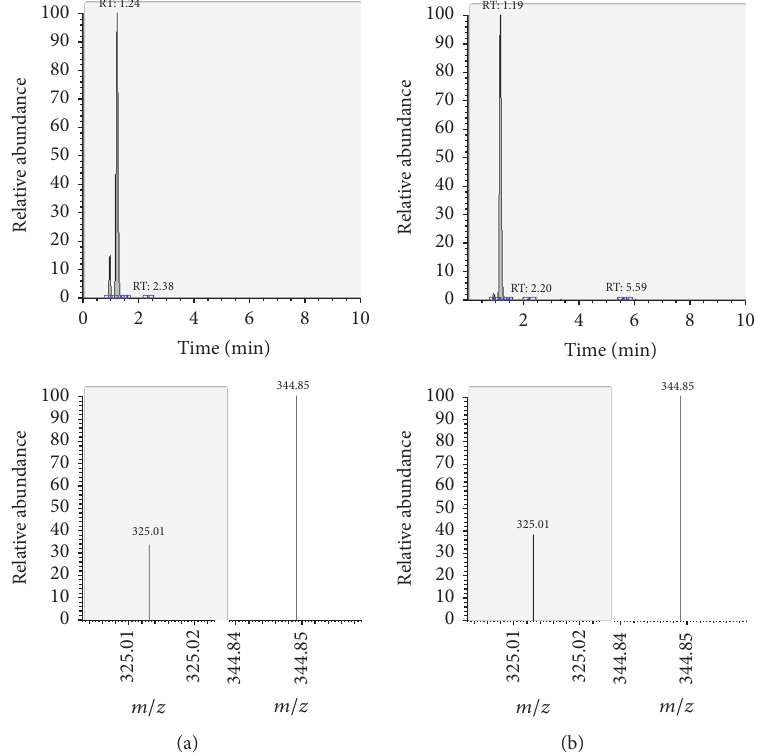
Figure 6: LC-MS/MS chromatograms of TRM and SRM transitions and relative abundances. (a) Standard in a 100 𝜇 g L −1 solution. (b) Standard in the spiked sample at 100mg kg −1 .